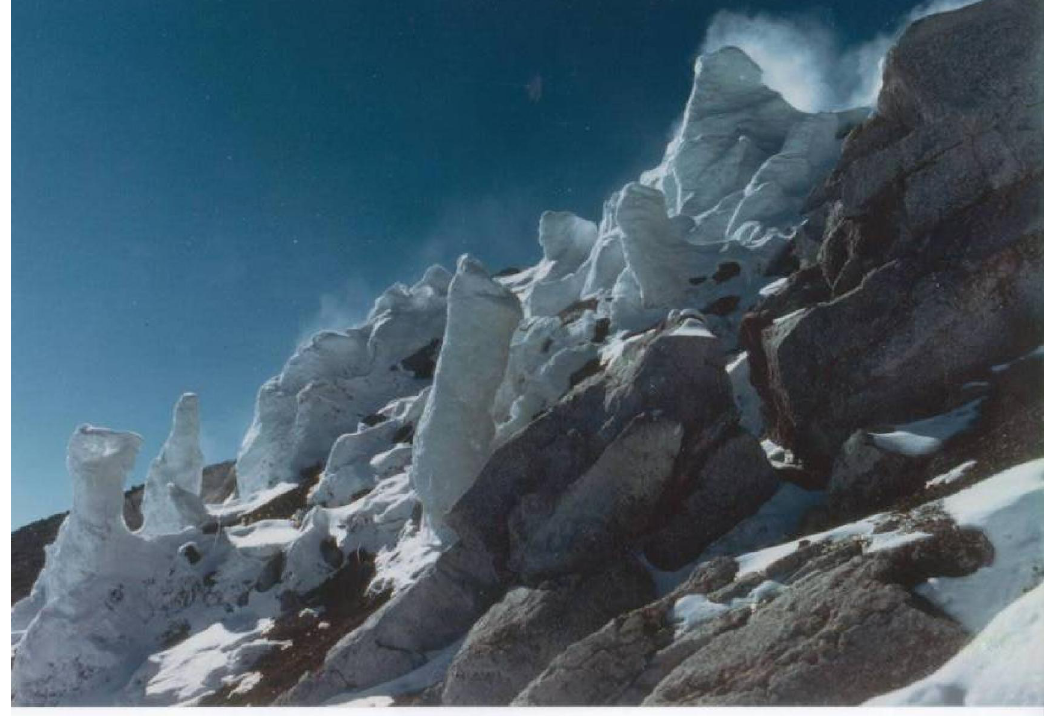
Figure 1. Ice Towers over Fumaroles at the Erebus Caldera, Antarctica. Some spires are over 2 meters high, consisting of ice derived from mostly recycled non-magmatic surface or subsurface waters. Fumarolic activity at Erebus is continuous and intensified during periods of volcanic eruptions (1841, 1900 (?), 1908, 1911, 1912, 1915, 1947, 1955, 1963, and 1972–1984). These dates as shown in the literature have been verified. Photo courtesy of Dr. E. Stump, Arizona State